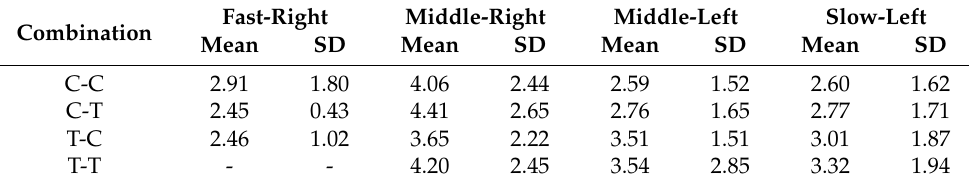
Table A13. The mean and standard deviation of THW of m and